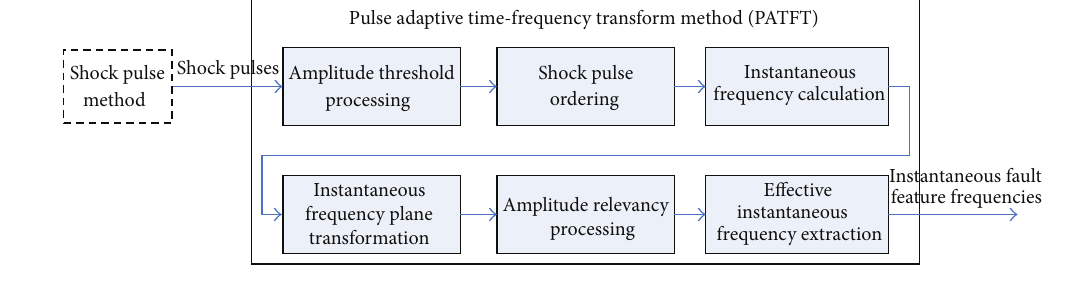
Figure 3: Steps of PATFTM.